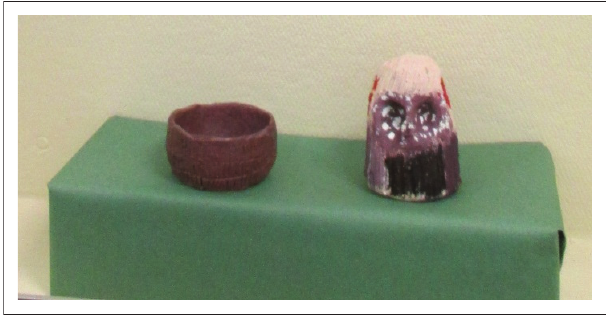
FIGURE 5: Pinch pot and clay-modelled owl.